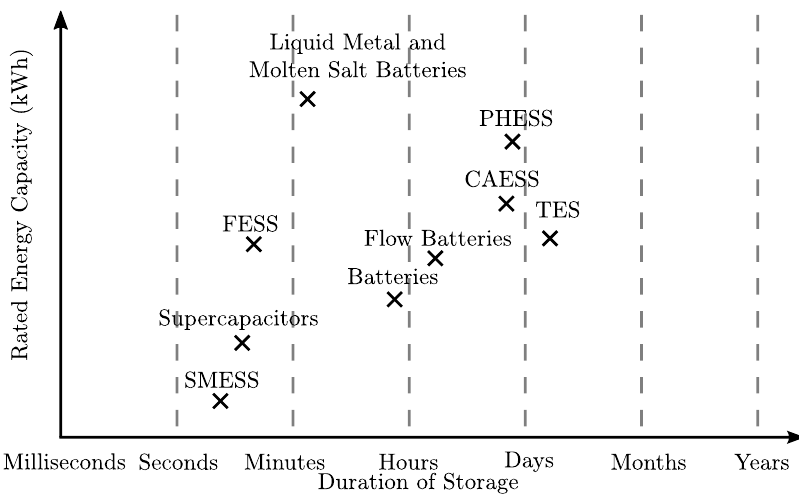
Figure 2. Rated energy capacity versus duration of storage of